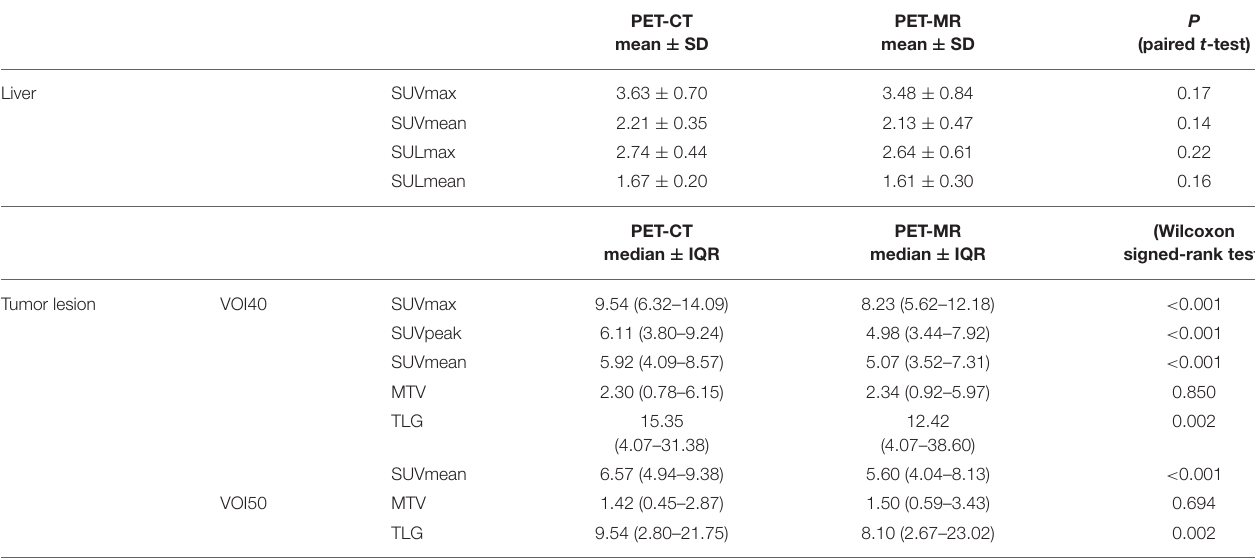
TABLE 2 | Details of SUV measurements in liver and tumor lesions.